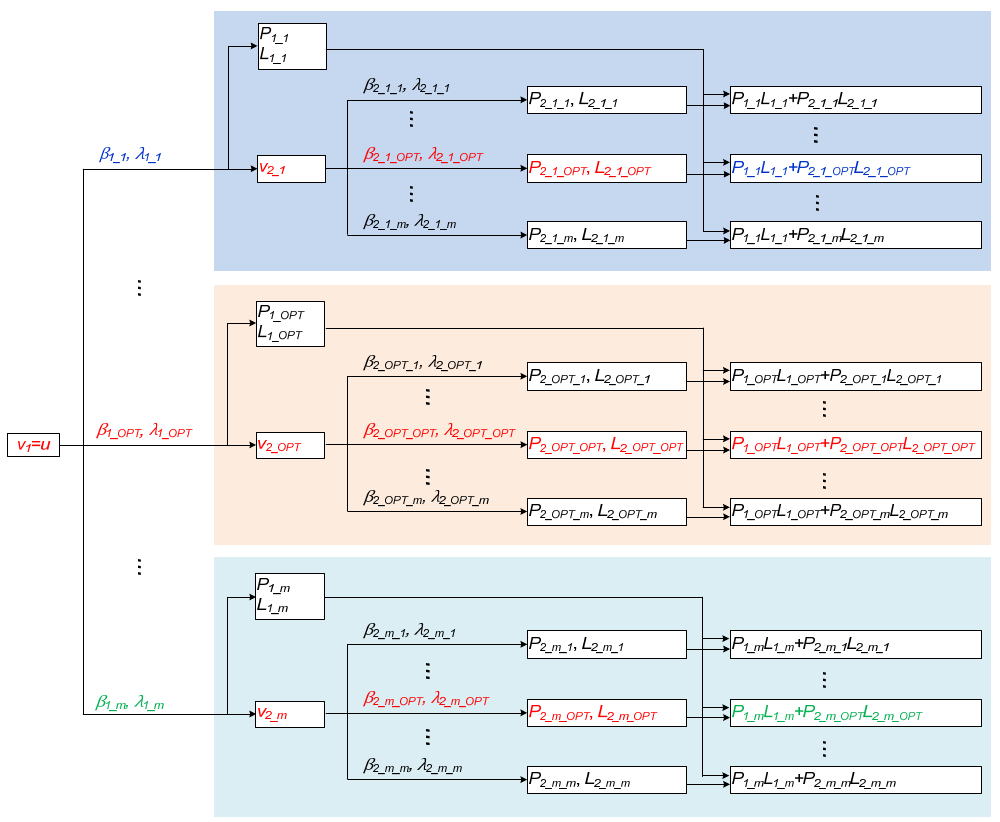
Figure 14. Flow chart to obtain the optimal pitch angle and tip speed ratio in the wind farm with two turbines.